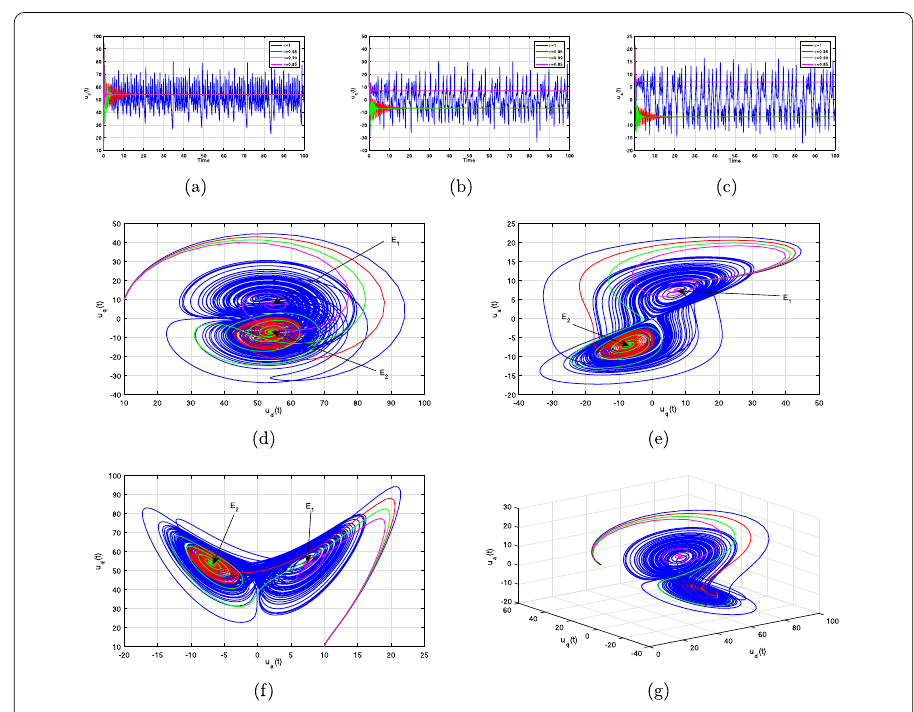
Figure 6 Simulations of Example 5 for time-fractional brushless DC motor (11) in the AB–Caputo sense